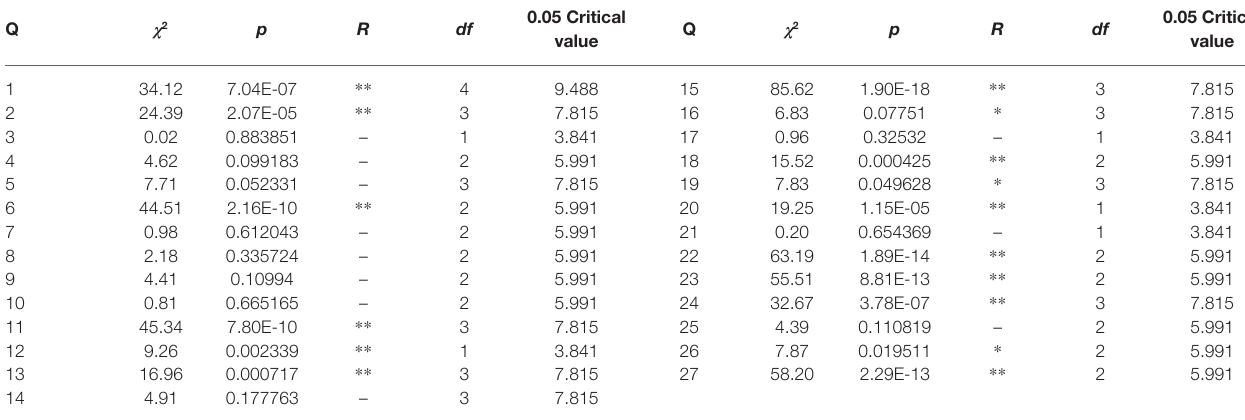
TABLE 10 | Chi-square test results (per the chi-square test critical value).